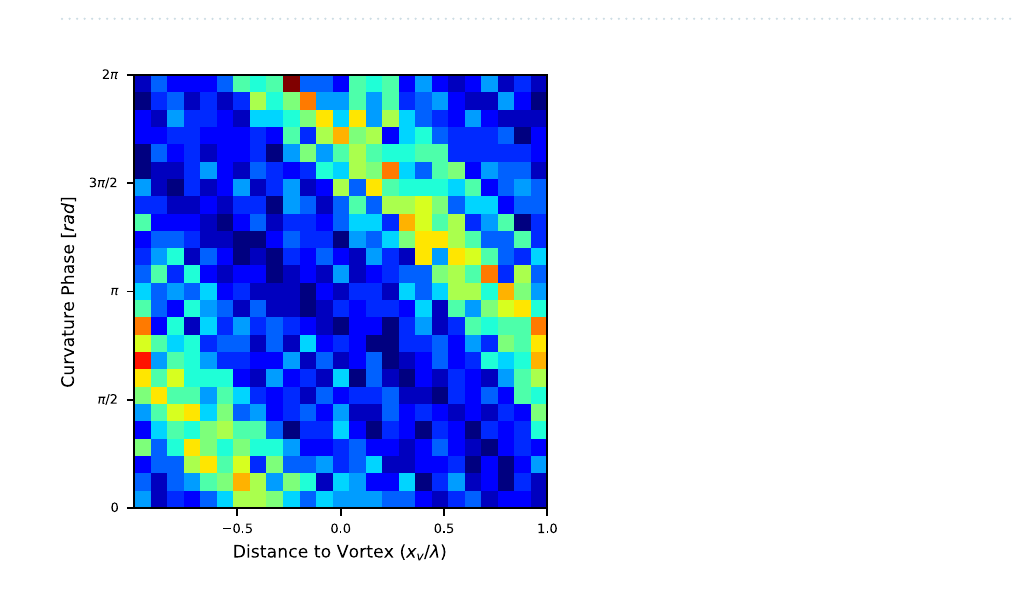
Figure 7. Fish muscle curvature at different phases of the fish streamwise position with respect to vortices. Blue—regular swimming outside the wake, red—swinging in the wake. Clear dependence of the curvature on the position in the vortex street suggests fish adjust the body shape to improve efficiency of interaction with the cross-flow. The figure shows data acquired from fish #1 swinging in the hydrofoil wake with an oscillation frequency of 2 Hz.